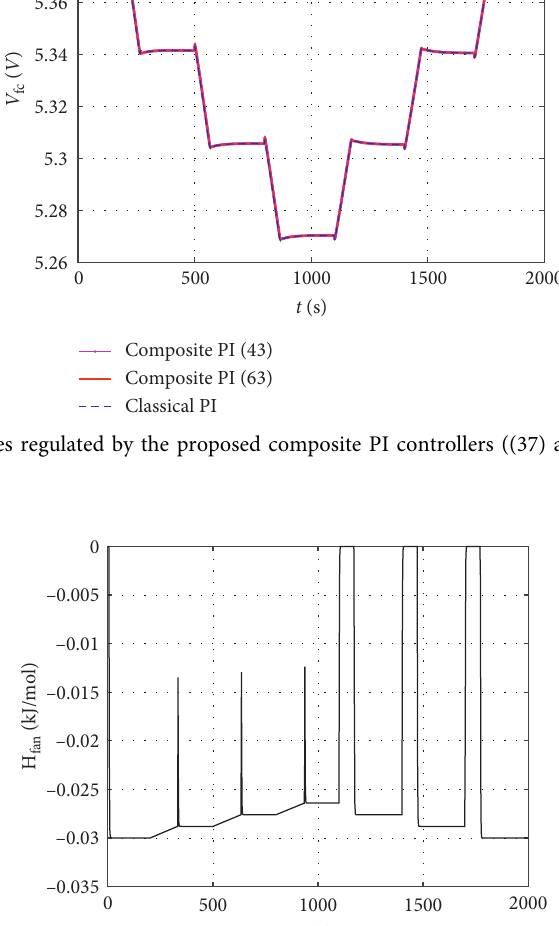
and D by the estimators ((29) and 1 2